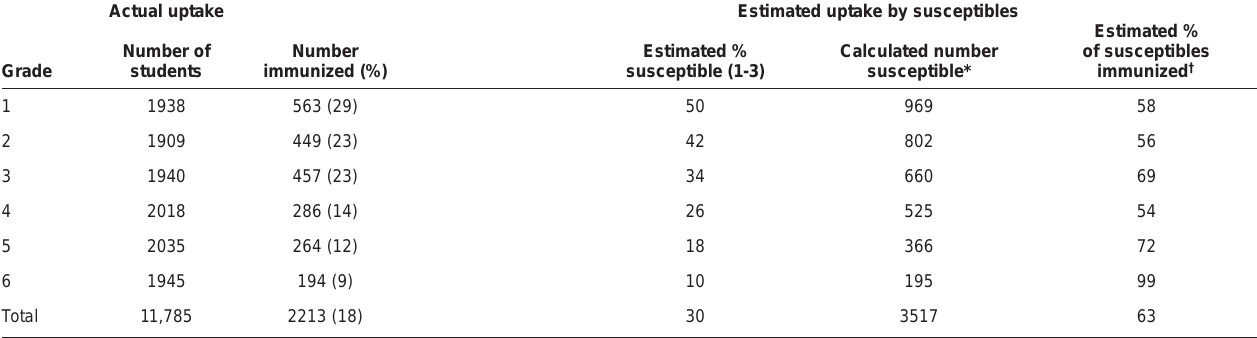
TABLE 1 Actual and estimated susceptible proportion of Prince Edward Island students receiving varicella vaccine by grade